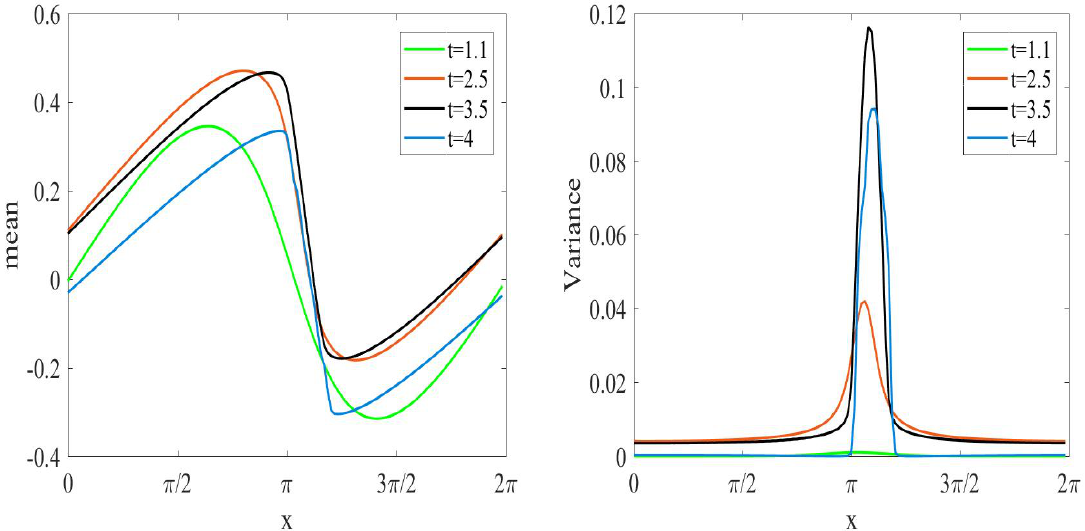
¯ u ( x , t ) ( left ) and its contour lines ( right ) for the inviscid Burgers’ Figure 15. The mean solution field ( left ) and its contour lines ( right ) for the Figure 15. The mean solution field equation using the DO method. inviscid Burgers’ equation using the DO method.   (  ,  )